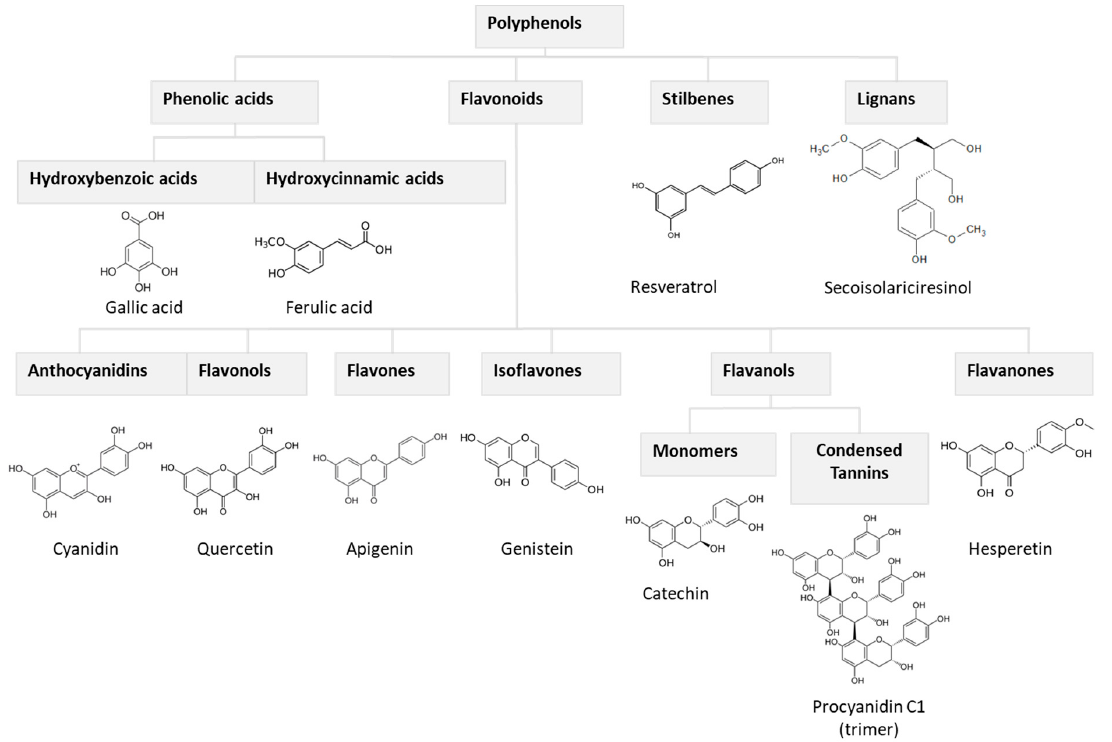
Figure 1. Classification of polyphenols according to their structures with some representative molecules of each family. (i) taric esters of these acids (e.g., caftaric and coutaric acids) are especially abundant in